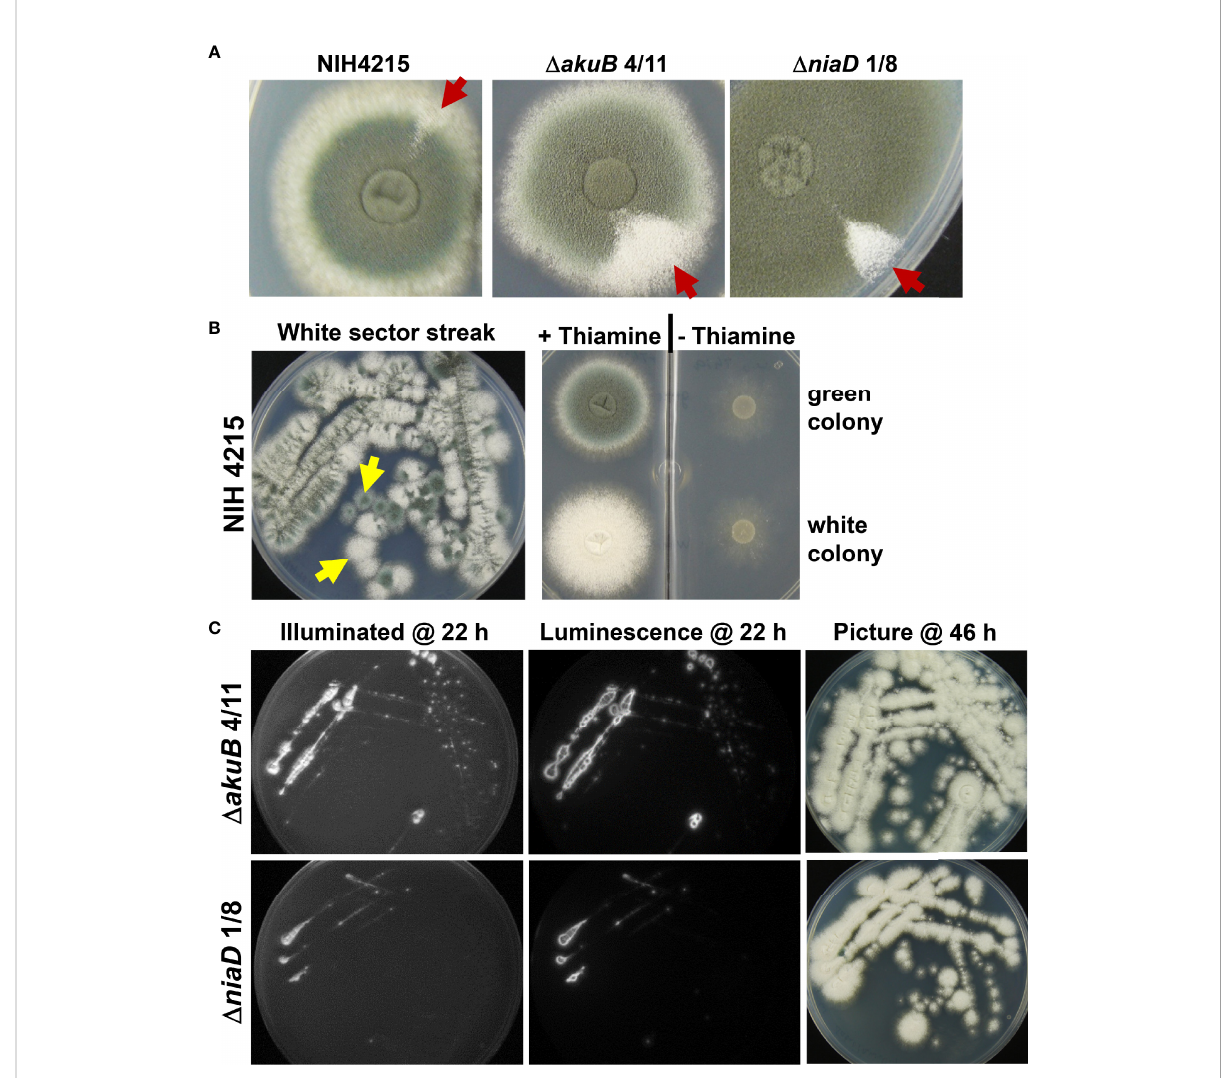
FIGURE 8 Phenotypic analysis of strains deriving from spontaneously occurring white colony sectors. (A) Visualisation of white sectors (arrows) arising on the edges of colonies of the parental strain NIH2415 and different transformants. Spores from the sectors were collected for further analysis. (B) Streak from white sector of the NIH2415 colony on thiamine containing glucose minimal medium at 46 h. Due to the small sector, a mixture of green and white colonies are growing. Spores from a green and a white single colony (arrows) were transferred to a petri dish with two compartments, one with and one without thiamine containing medium. At 48 h, the green and the white colony both show the expected thiamine auxotrophy of the parental strain. (C) Analysis of bioluminescence and conidia colouration of white sectors streaks from the D akuB and the D niaD strain. Conidia from sectors were transferred to glucose minimal medium containing 0.3 mM D -luciferin and were incubated at 37°C. Luminescence was analysed after 22 h at which initial mycelium formation becomes visible. The mature colonies with white conidia are shown after 46 h of